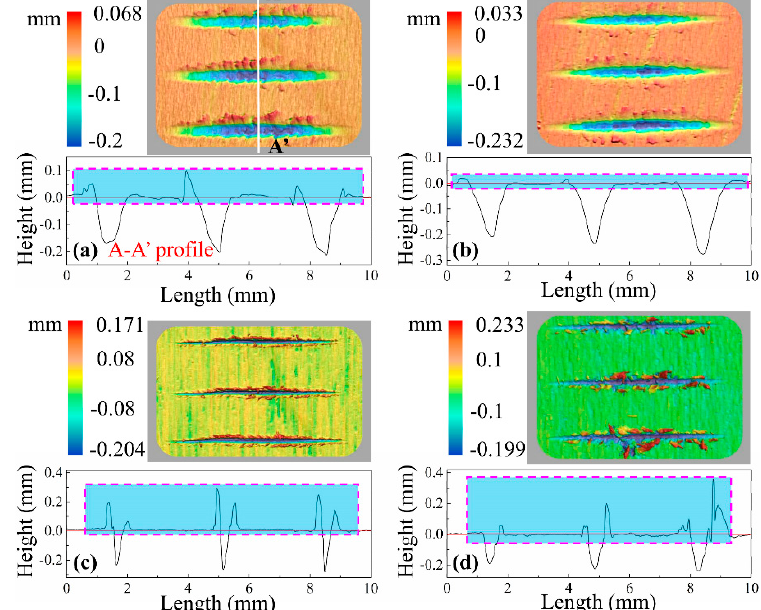
Figure 8. 3D morphology and 2D cross-sectional profiles of typical scratches ( λ = 90 ◦ ) cut by: ( a ) spherical cone tool with 2 α = 84 ◦ , ( b ) spherical cone tool with 2 α = 108 ◦ , ( c ) triangular pyramid tool with one main cutting edge and two side cutting edges, and ( d ) triangular pyramid tool with two main cutting edges. Note: the 2D cross-sectional profiles were extracted from the deepest point of the scratch like the A-A’ profile.